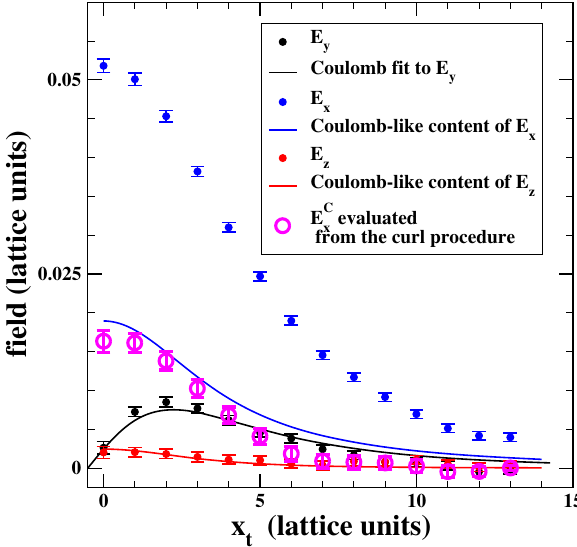
Fig. 3 The three components of the chromoelectric field measured at β = 6 . 240, d = 16 a = 1 . 02 fm, for x = 4 a and the three components l of the perturbative Coulomb field, obtained from fitting the transverse E y field component to the form